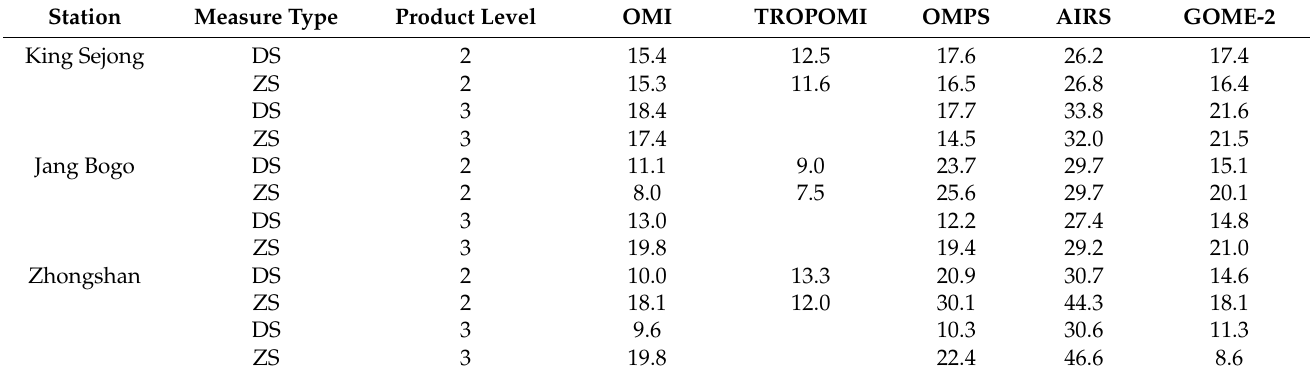
Table 3. The RMSE values for satellite data at each station (unit: DU).